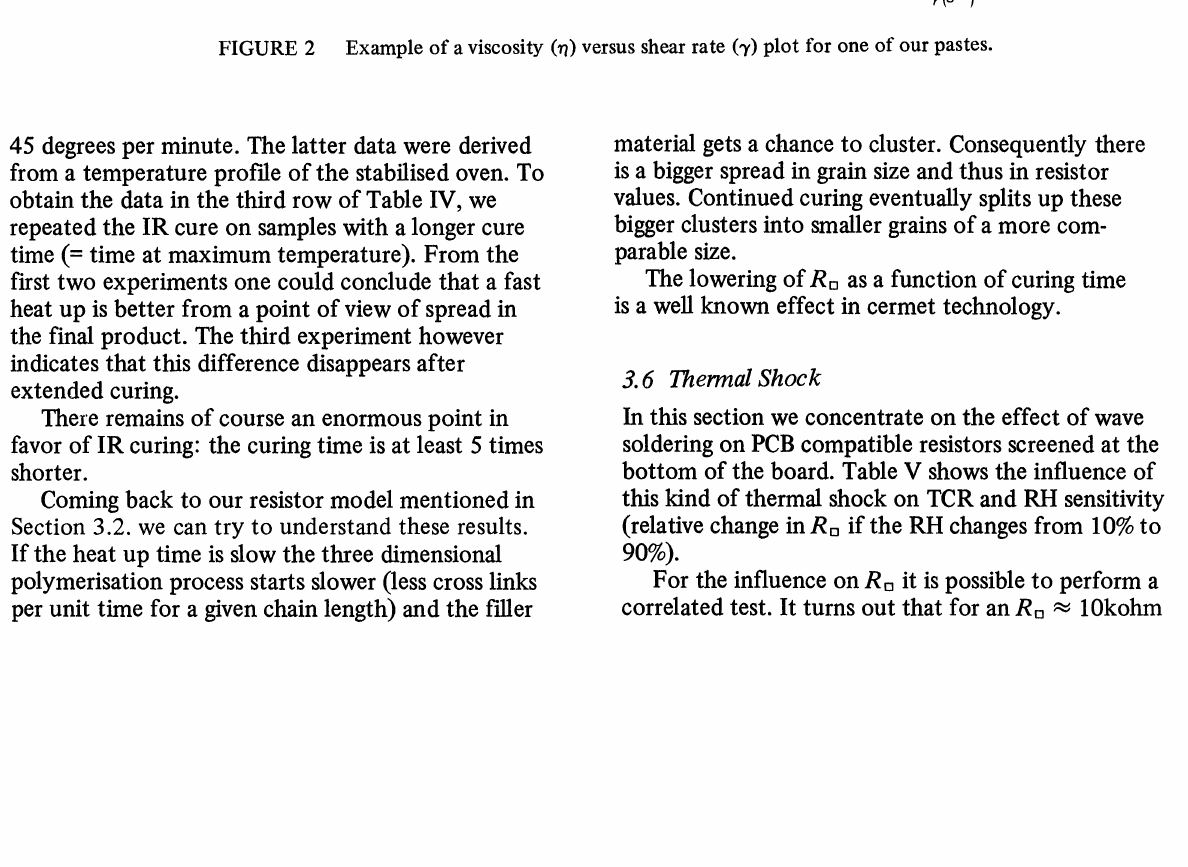
Example of a viscosity (r/) versus shear rate () plot for one of our